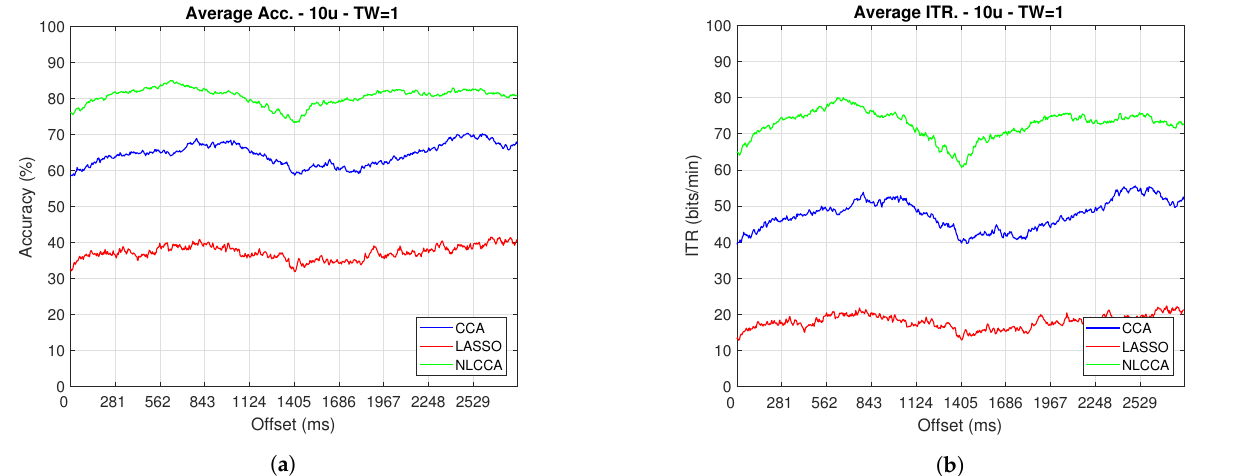
Figure 11. One–second sliding window (trimmed 50 first data—200 ms) of ( a ) Accuracy and ( b ) ITR. On the other hand, considering the steady-state (around 200 ms later), the phase- shifting effects are still observed. These effects produce variations in the accuracy and ITR performances, which were analyzed using the coefficient of variation. In addition, some slight differences that appear between NLCCA with and without transient responses were observed, which other approaches do not have. These differences are due to different a better performance. Table 2 shows the mean, standard deviation, and coefficient of variation data for each of the signals presented in Figures 11 and 12. It can be seen that the mean of NLCCA is higher than the other two methods, both in precision (80–86) and ITR (72–79), and the standard deviation is similar in all three methods. This results in the coefficient of variation of NLCCA being the lowest in all cases (2.37 to 4.22), thus indicating that this method is more